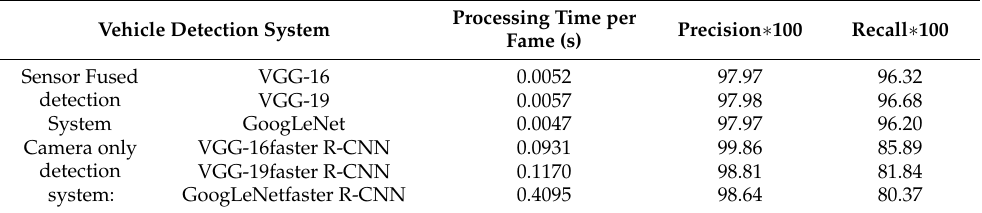
Table 5. The performance comparison: sensor fused RCT detection system vs. camera-only detec- tion system.